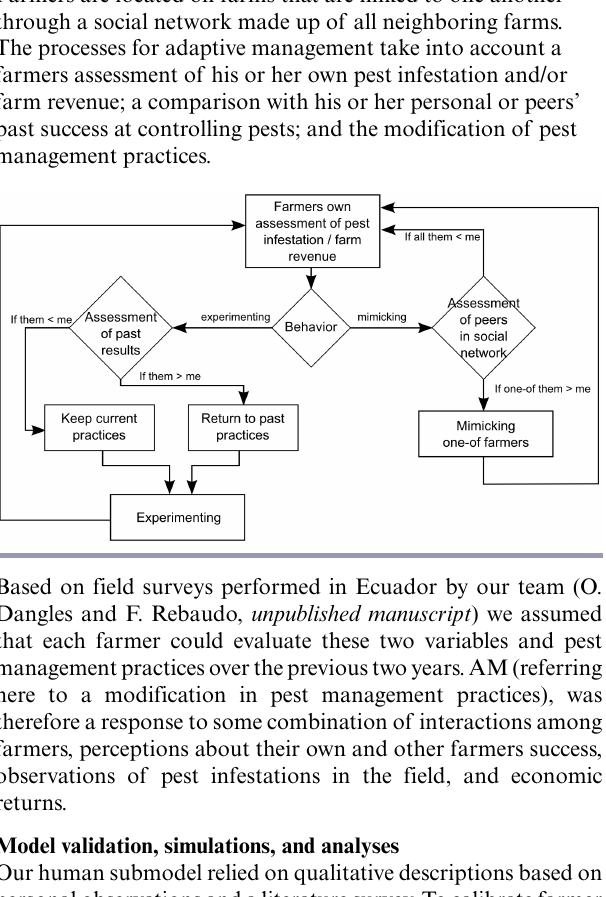
Fig. 2 . Representation of adaptive management in pest control. Farmers are located on farms that are linked to one another through a social network made up of all neighboring farms.